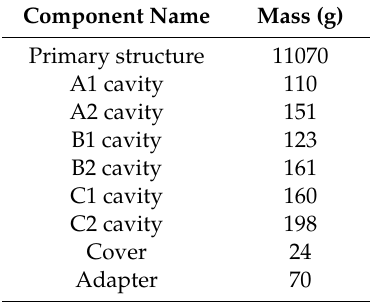
Table 4. Mass of each component.